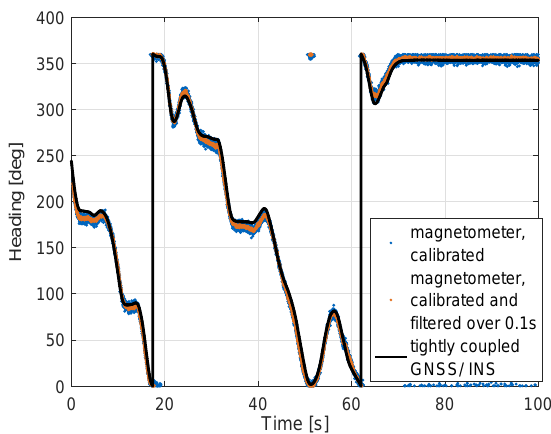
Figure 6. Heading determination with calibrated magnetometer in comparison to tightly-coupled GNSS/INS heading: the latter one has an accuracy of 0.25 degrees and serves as a reference. As the magnetometer-based heading is noisy, a filtered version with a time constant of 0.1 s is also shown.